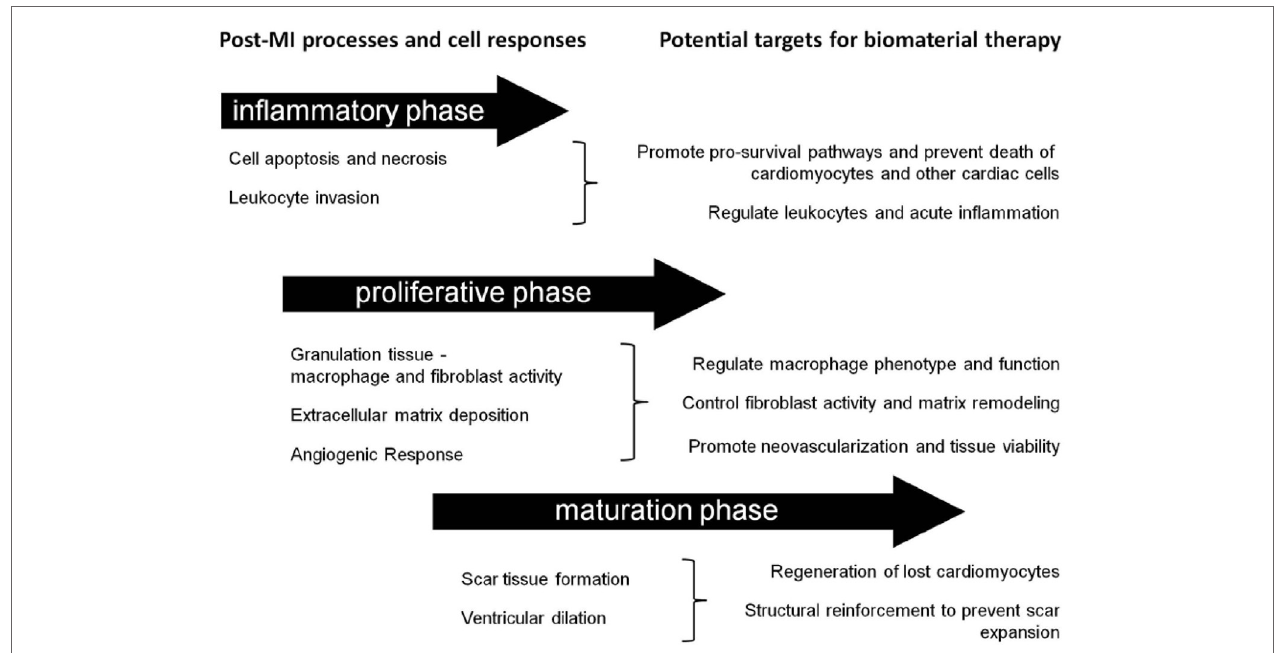
FiGURe 2 | Timing considerations for the application of biomaterial therapies . This schematic summarizes the timeline of post-MI processes and identifies some associated potential cellular targets for biomaterial therapy.